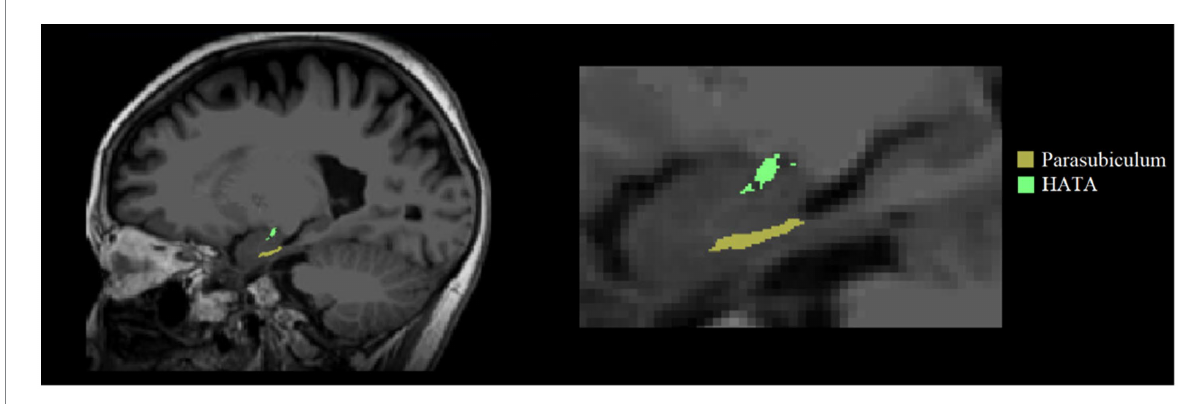
FIGURE 2 Left two hippocampal subregions with significant volume changes after intervention.